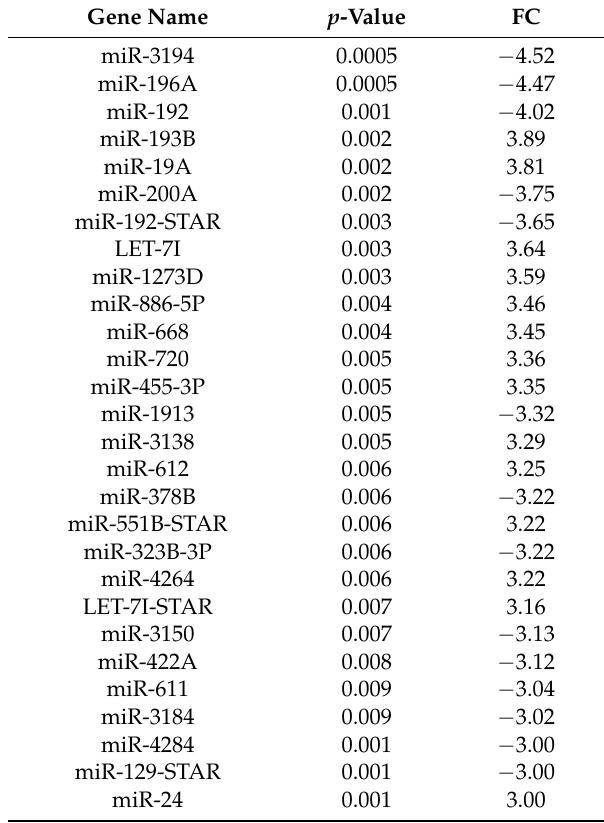
Table 1. Expression changes in the most deregulated microRNAs in Crohn’s disease. FC (fold change); STAR (antisense